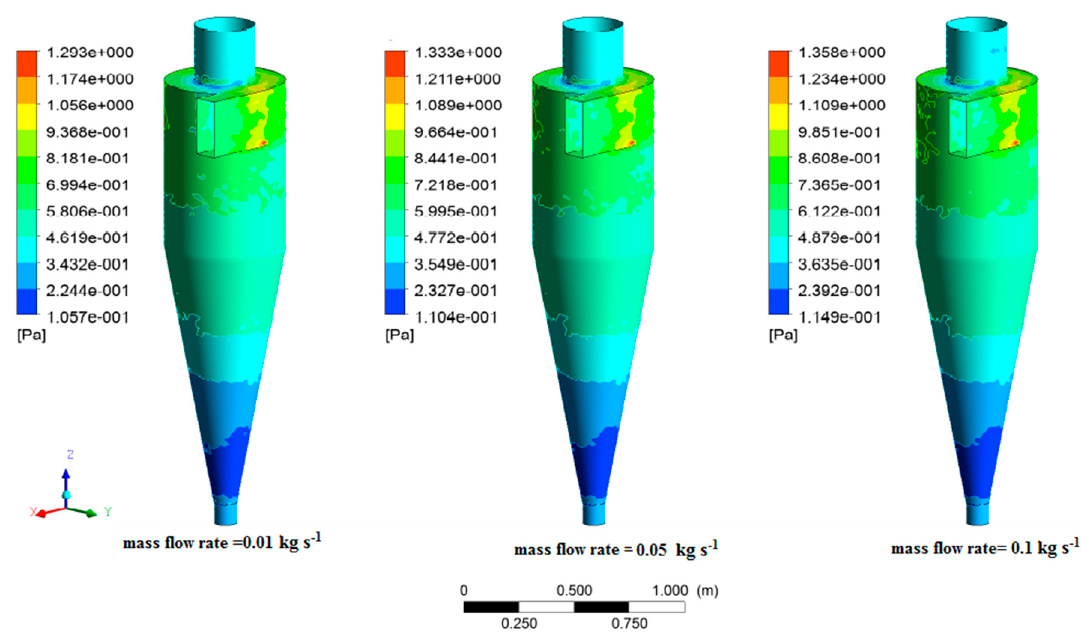
Figure 18. Wall shear 3D contours in various mass flow rates.